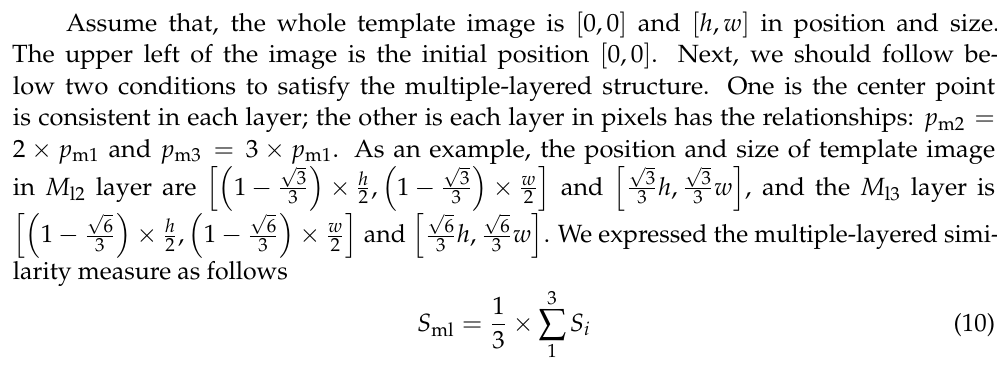
Figure 9. The concept and merit of multiple-layered